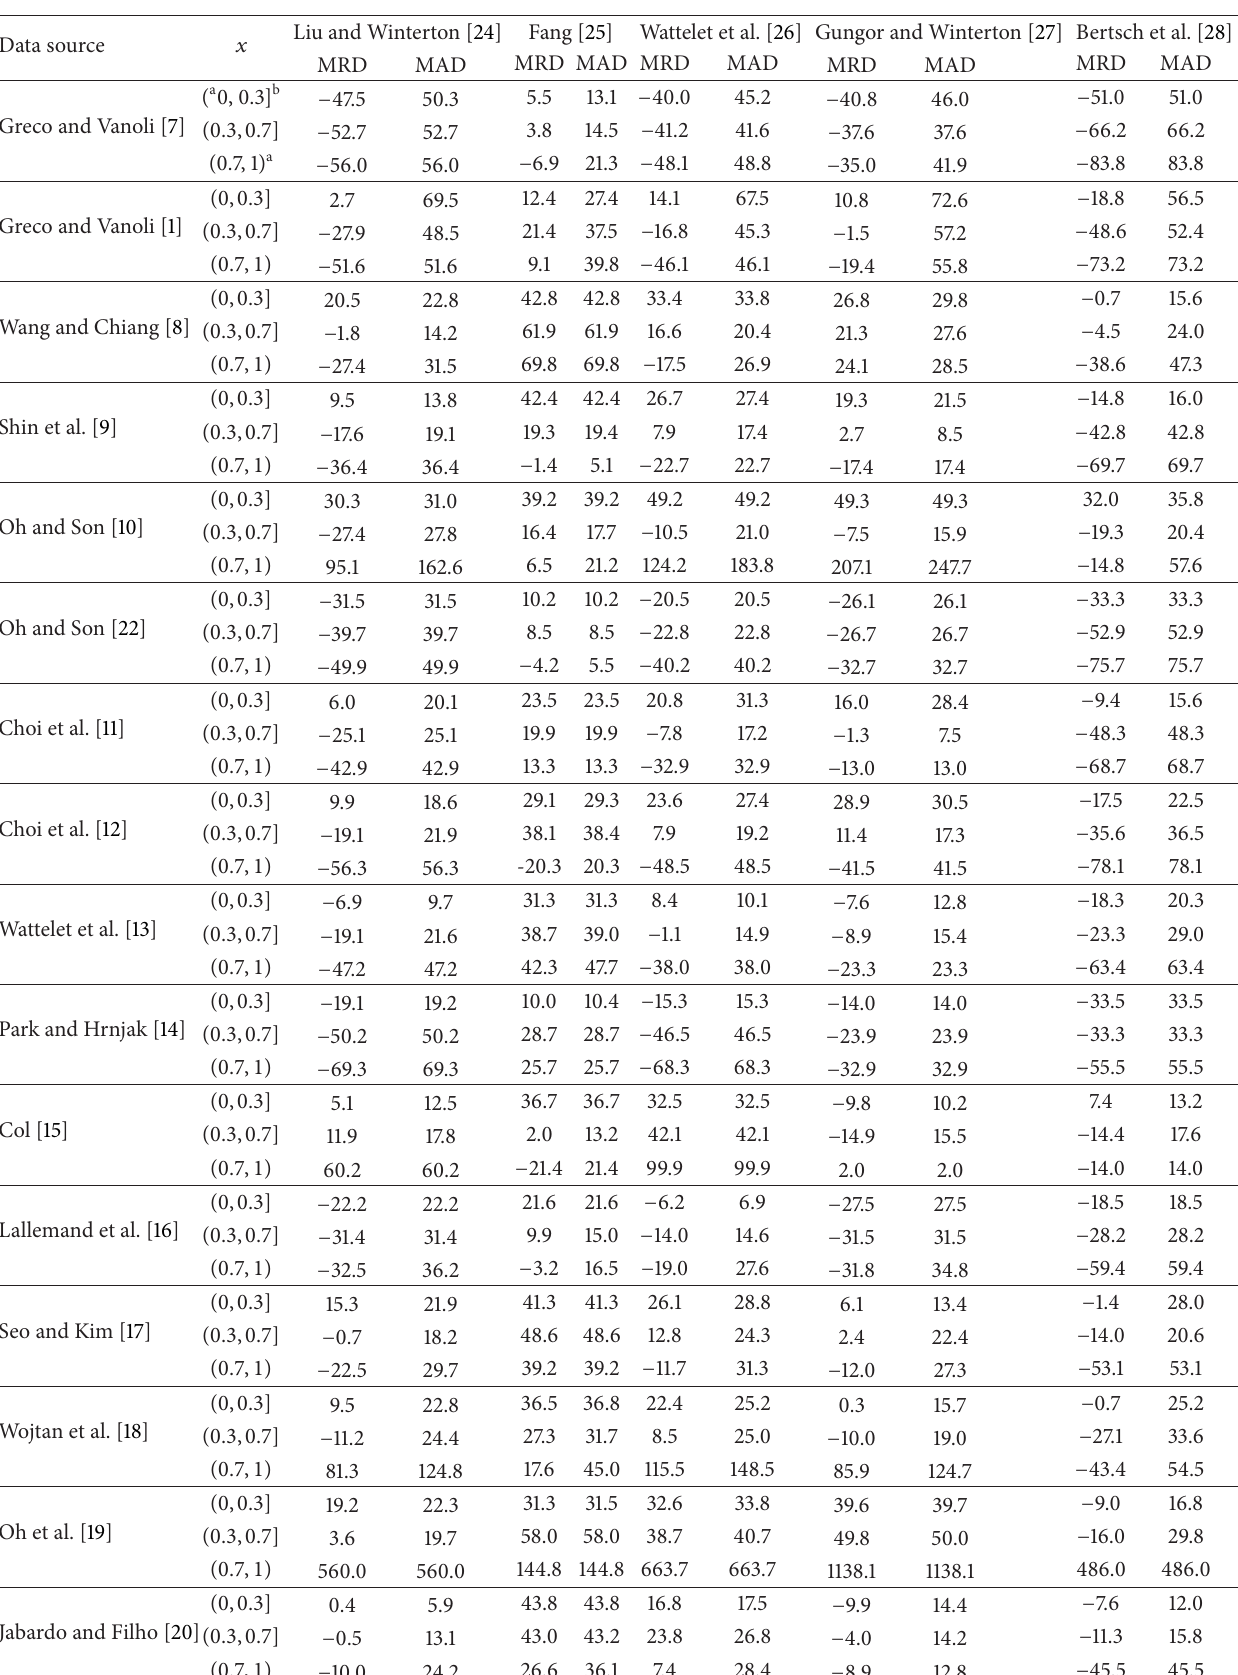
Table 5: Deviation of the top 5 correlations for different quality bands (%). Data